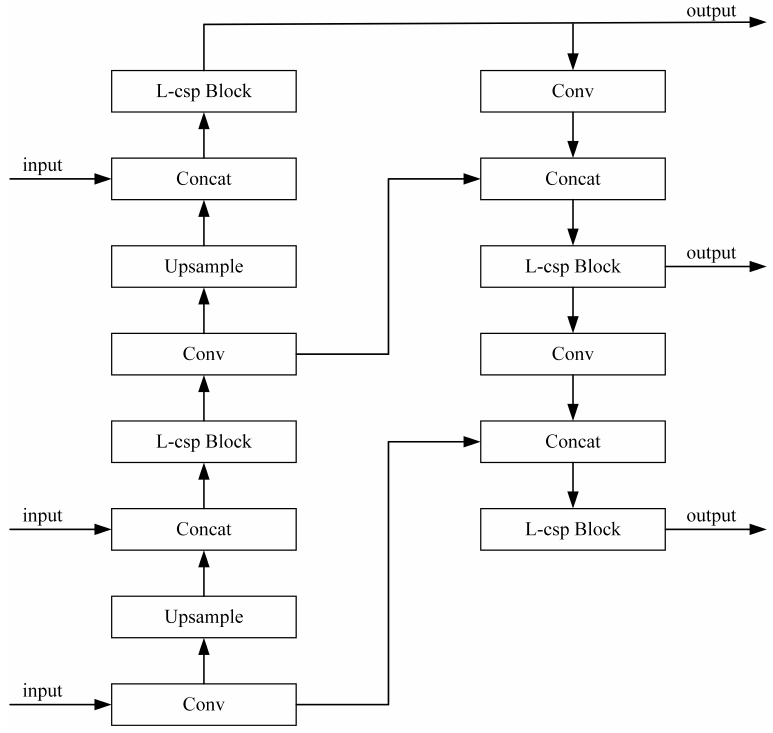
Figure 8. The structure of the L-PAFPN